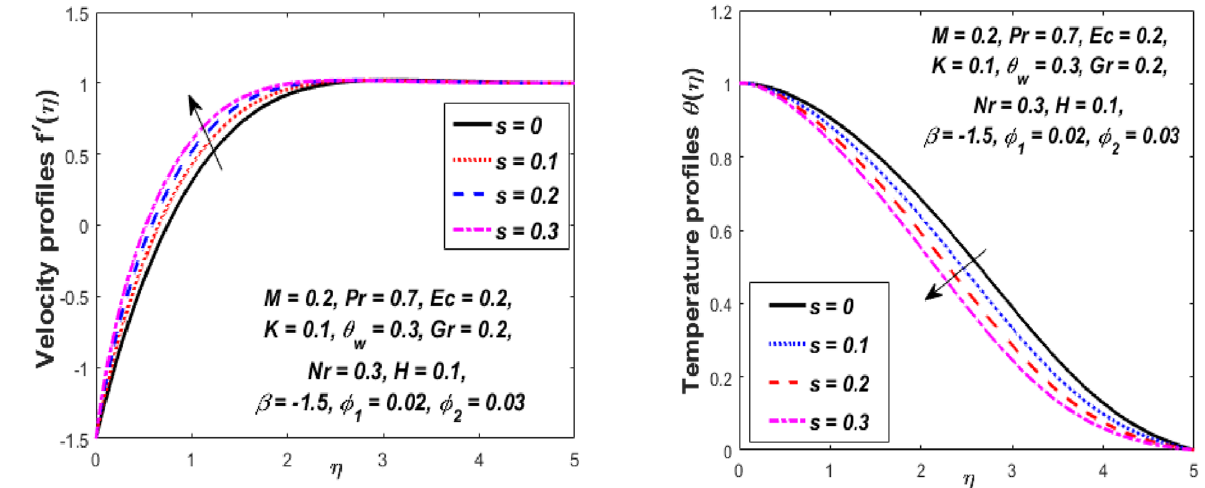
Figure 5. Influence of s on velocity f ′ (η) and temperature θ(η) profiles.